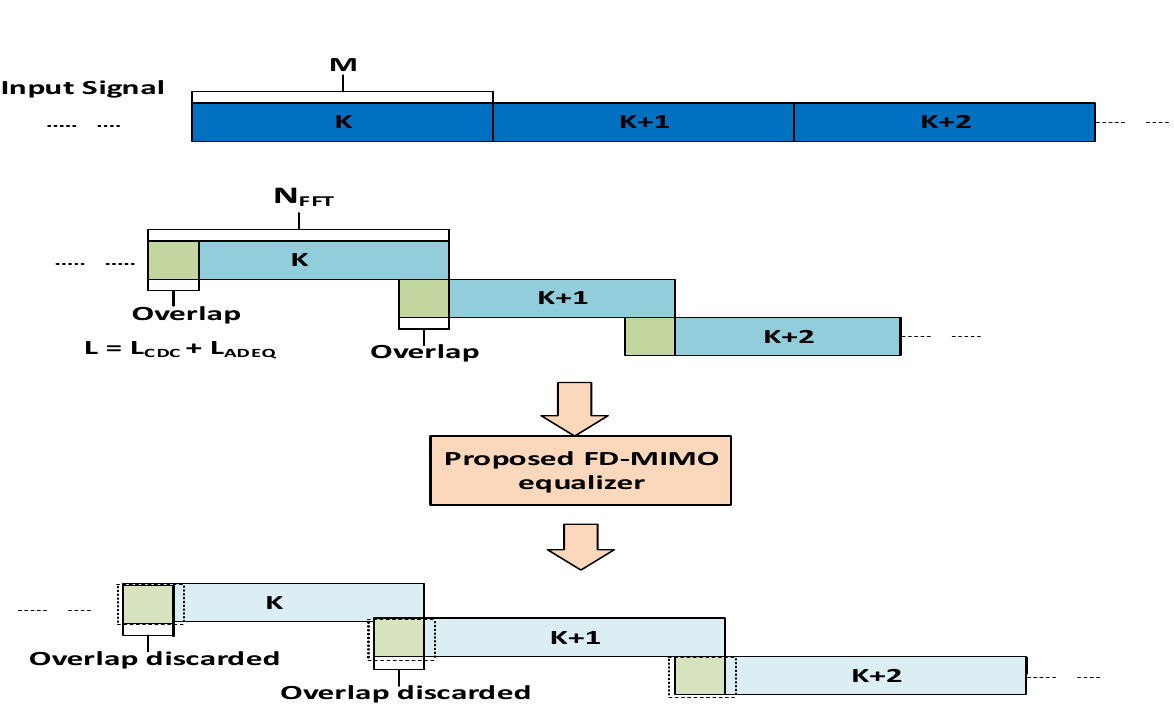
Figure 2. Procedure of frequency domain multiple in multiple out (FD-MIMO) equalizer.